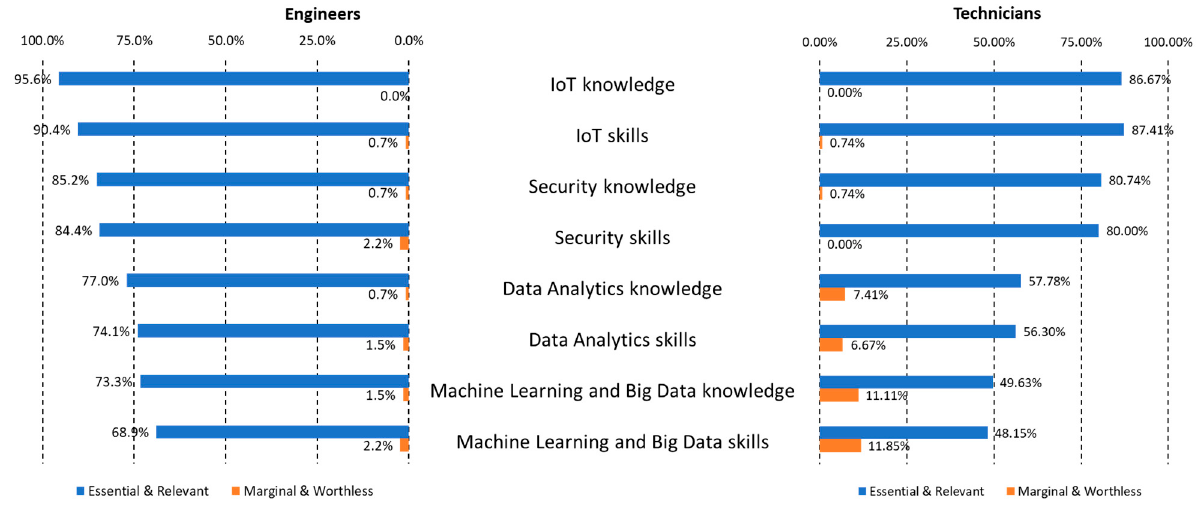
Figure 4. Summary of perceived relevance for skills and knowledge.